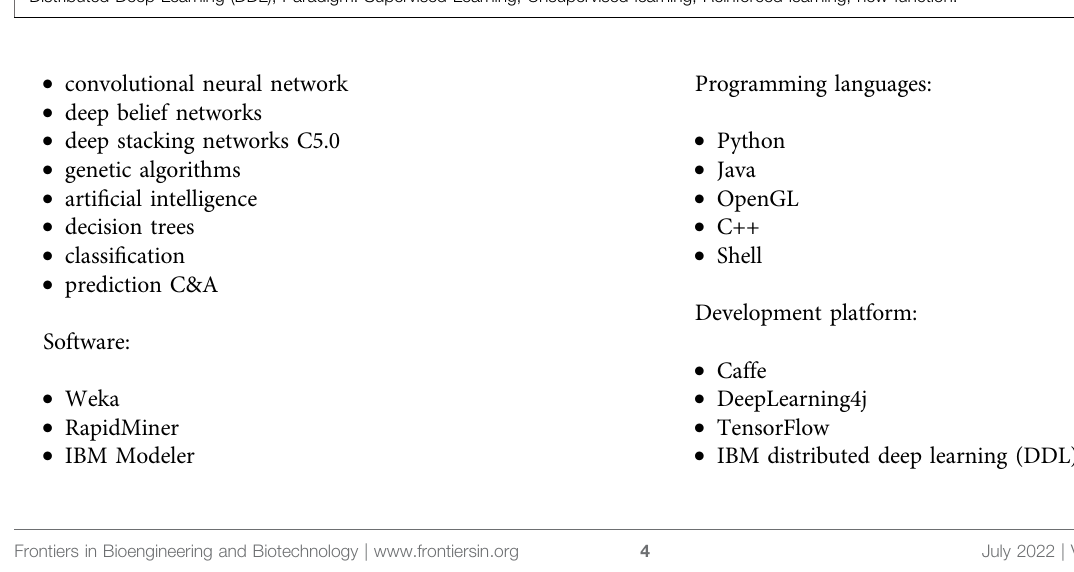
Frontiers in Bioengineering and Biotechnology |